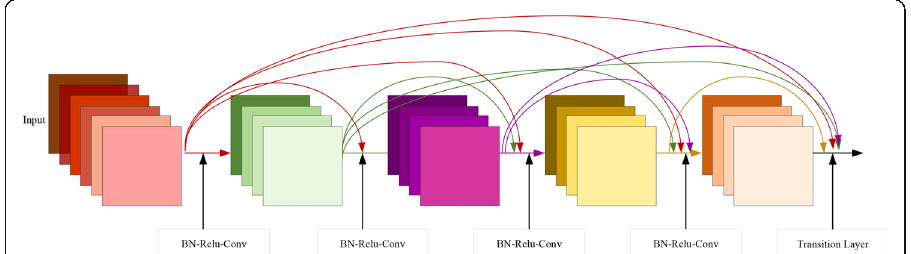
Fig. 11 DenseNet network structure